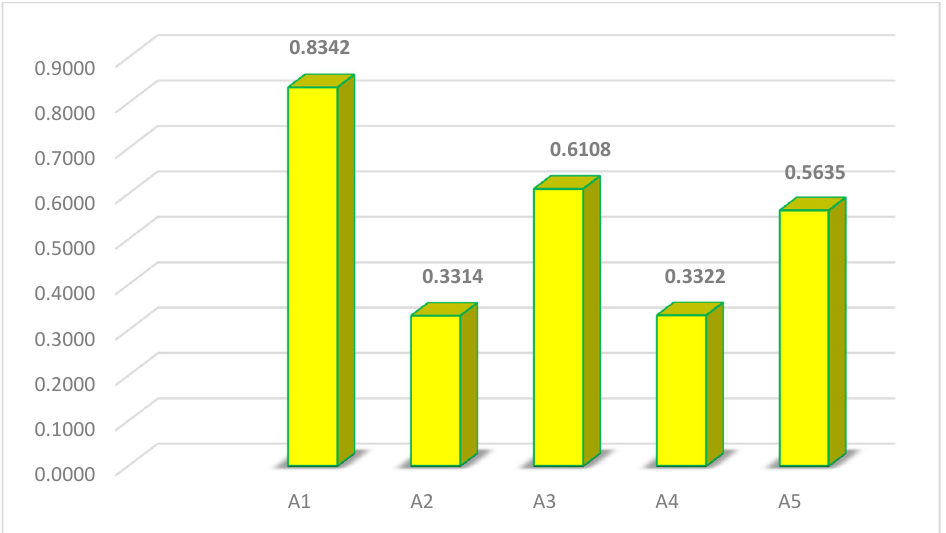
Figure 4. Digital marketing technologies ranking list. Table 7. Ranking score. Table 8. Comparing results with TOPSIS with equal weights Ci